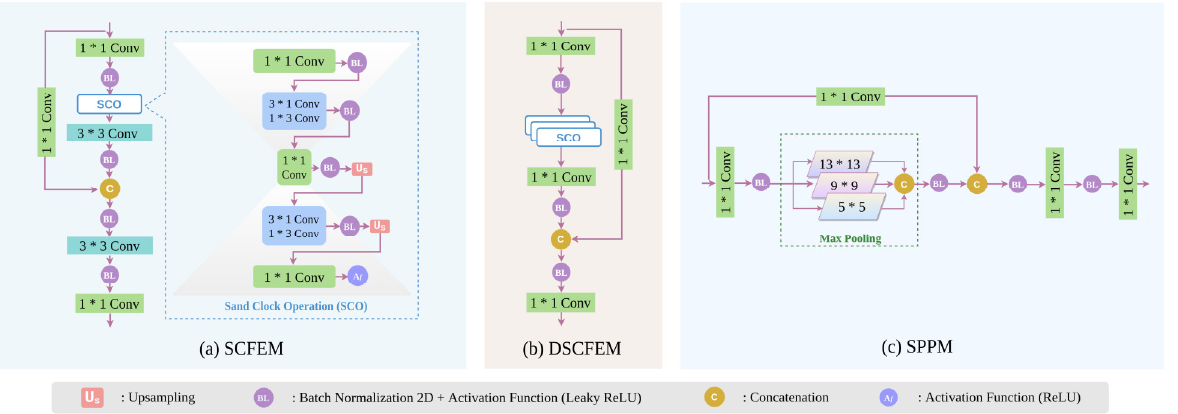
Figure 4. The detailed demonstration of several key modules in YOLO-JD. ( a ) Shows the architec- ture of the Sand Clock Feature Extraction Module (SCFEM). ( b ) Shows the details of the Deep Sand Clock Feature Extraction Module (DSCFEM). ( c ) Shows the Spatial Pyramid Pooling Module